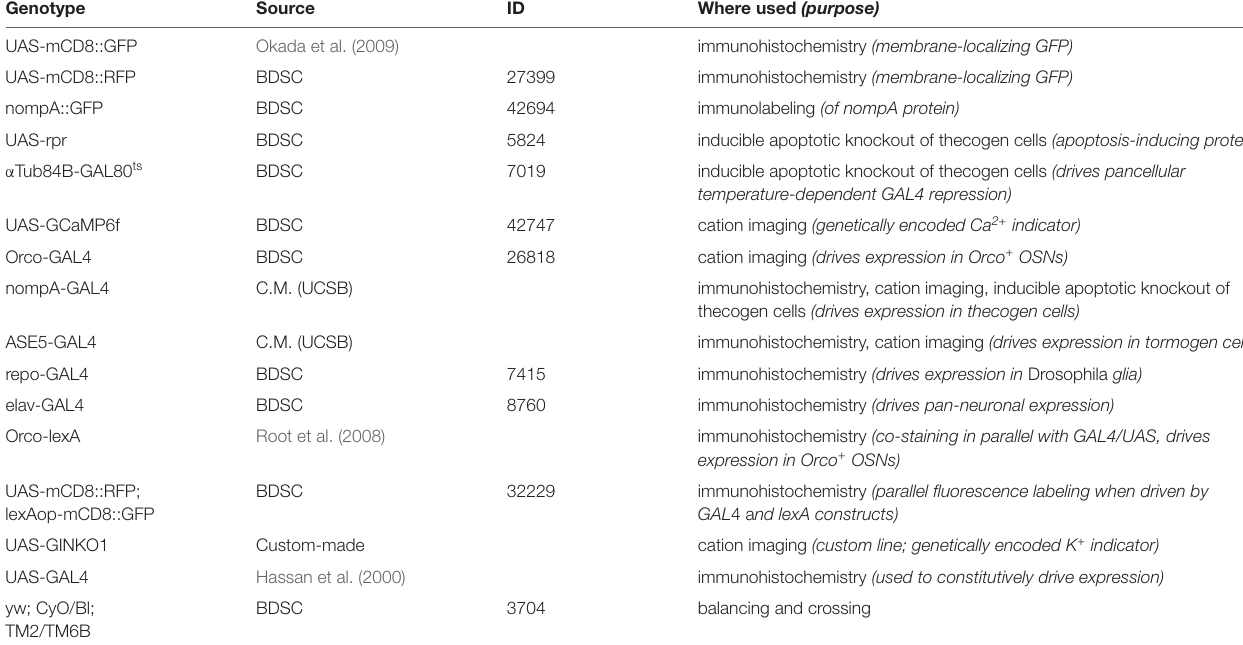
TABLE 1 | List of transgenic fly lines used.